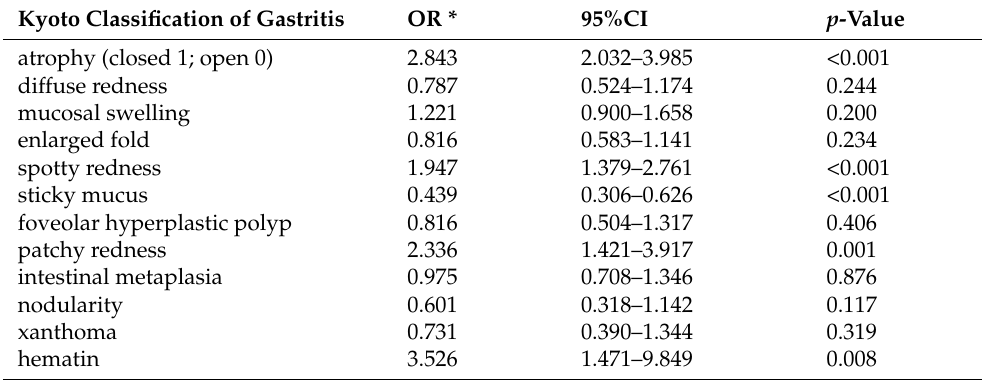
Table 5. Odds ratios of each endoscopic feature in the Kyoto Classification of Gastritis between the Tokyo and Okinawa groups in logistic regression